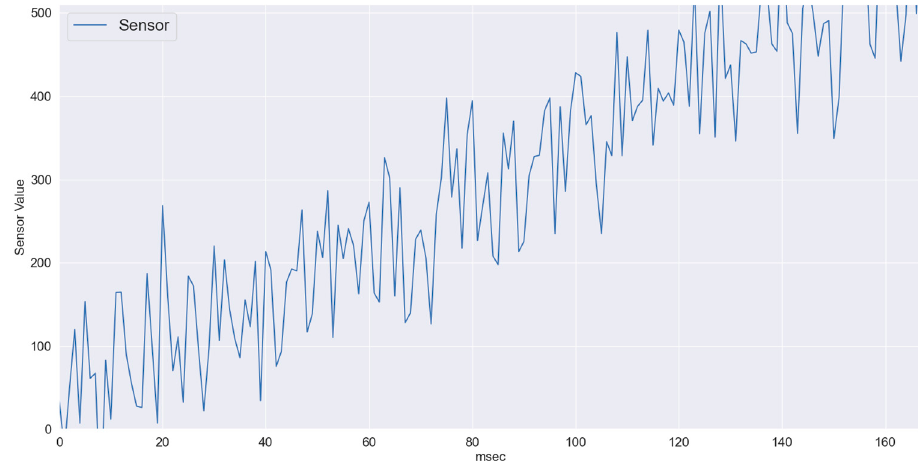
Figure 5. Varying Sensory Data.